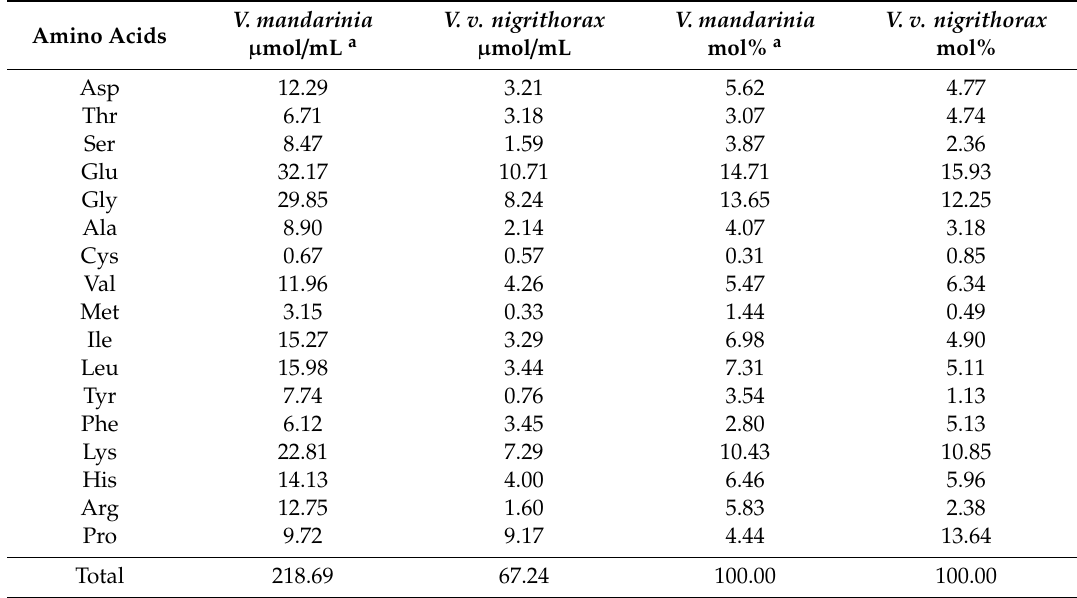
Table 3. Hydrolyzed amino acid compositions of larval saliva of V. v. nigrithorax compared to that of V. mandarinia . Amino